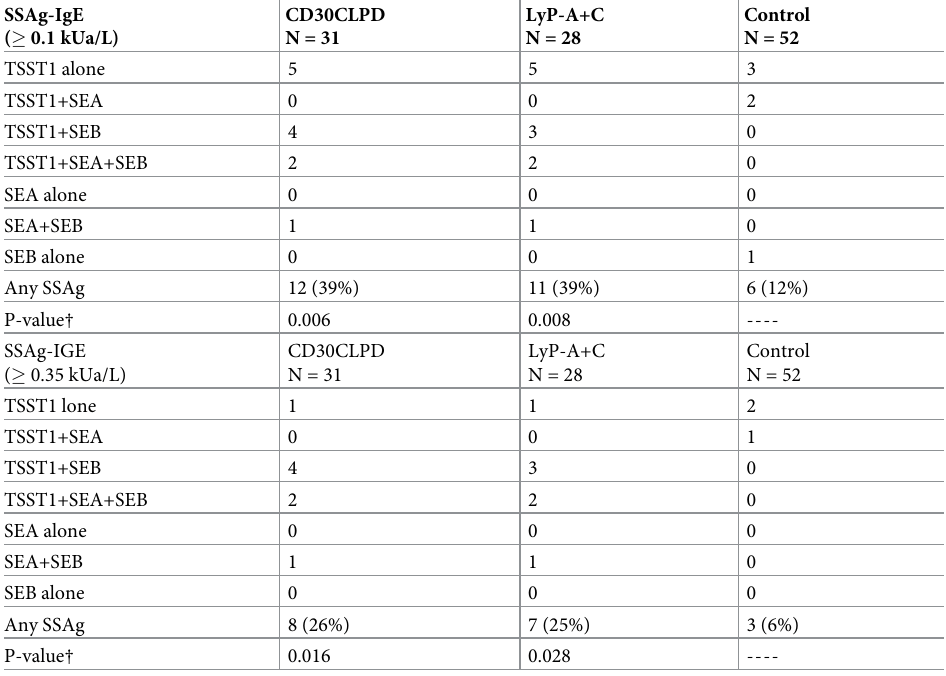
† Frequency of positive test, disease versus control groups, Fisher’s exact test CD30 expression in the skin specimen obtained at the time of blood sampling. Samples with higher numbers of CD30+ cells in the skin versus lower numbers, i.e., LyP-C/pcALCL vs.